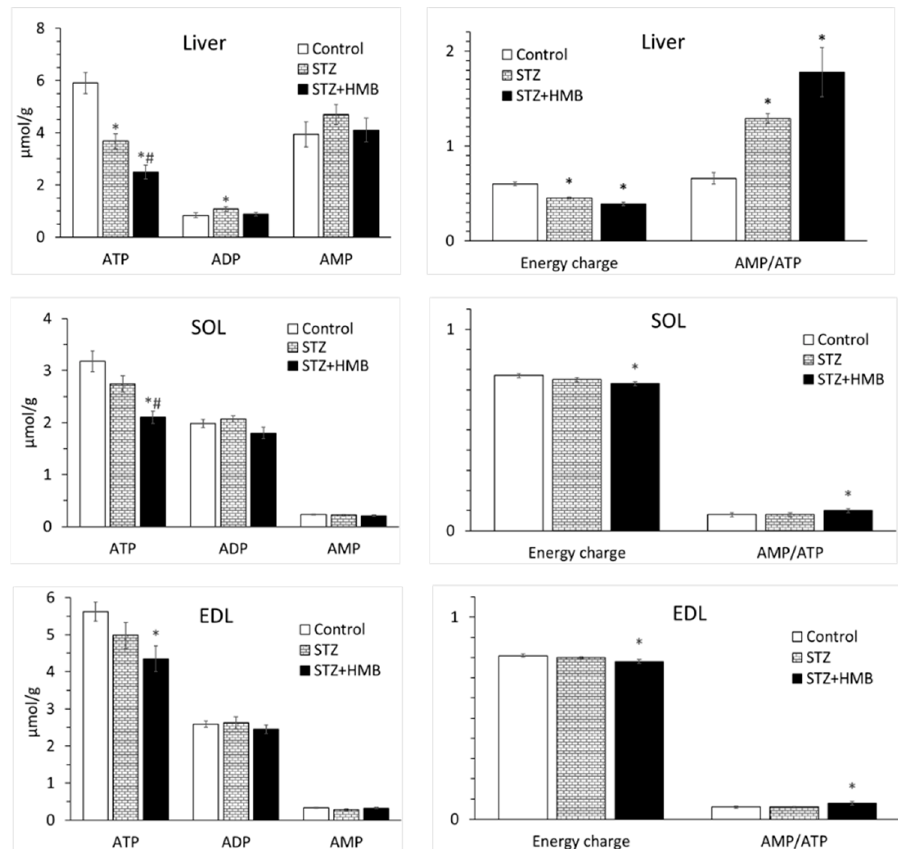
Figure 1. Effect of STZ and HMB on adenine nucleotide concentrations, cellular energy charge, and the AMP-to-ATP ratio in the liver and muscles. Means ± SE, p ˂ 0.05. ANOVA and Bonferroni multiple comparisons. * Comparison vs. Control. # Comparison of STZ + HMB vs. STZ. The equation for cell energy charge was: [ATP + (0.5 × ADP)]/[ATP + ADP + AMP].STZ, streptozotocin; HMB, β -hydroxy- β -methyl butyrate. SOL, soleus muscle; EDL, extensor digitorum longus muscle.